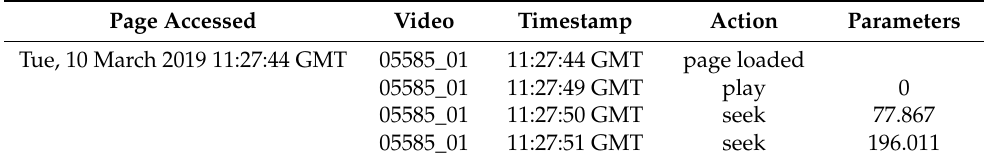
Table 2. An example of the collected data for a typical session. Parameters are described in the